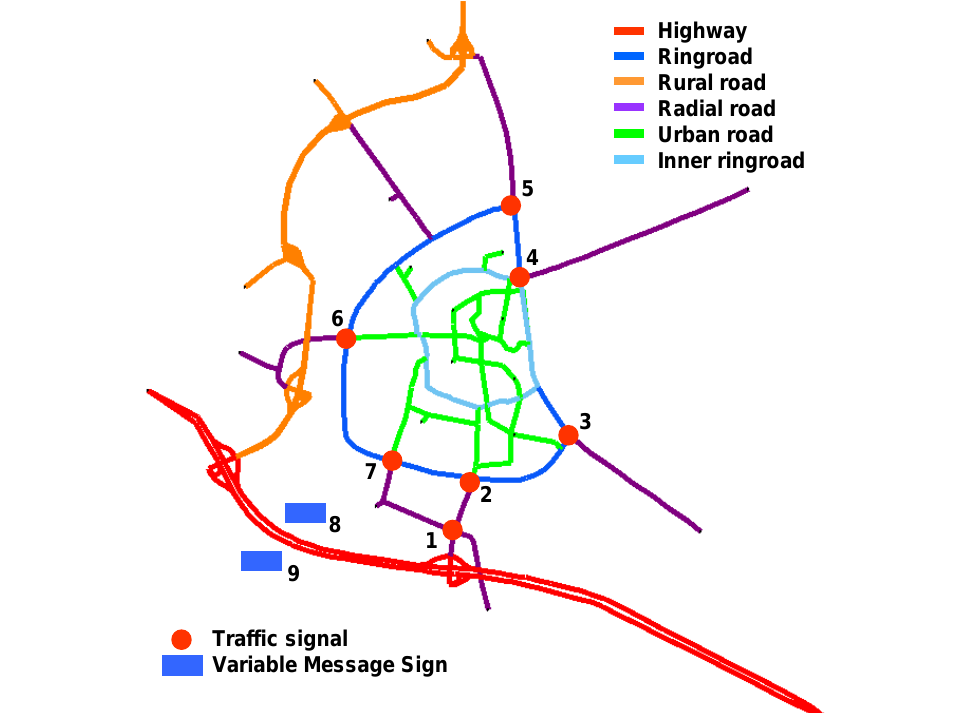
Figure 1. Network